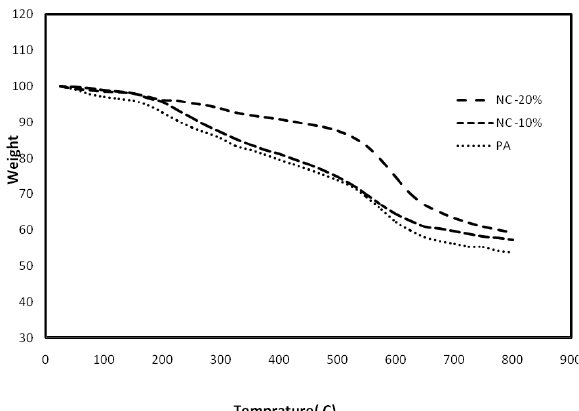
Figure 8. TGA thermograms of neat PAI 4 and PAI- nanocomposite films 4a and